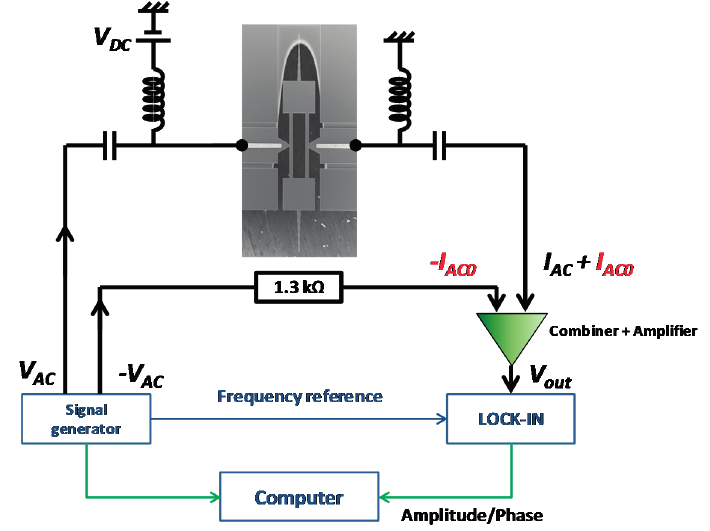
Figure 8. Schematic representation of the differential measurement to compensate I AC0 .